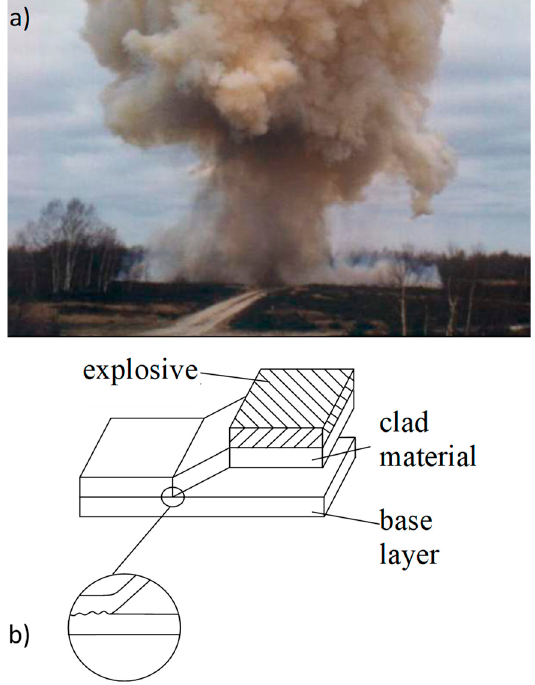
Figure 6. Explosive-welding of bimetallic sheets ( a ), schematic view of the process ( b ) . The composites were obtained by means of a constant stand-off explosive-cladding technique. A detonator was placed in the middle of the plate, close to one of the edges.